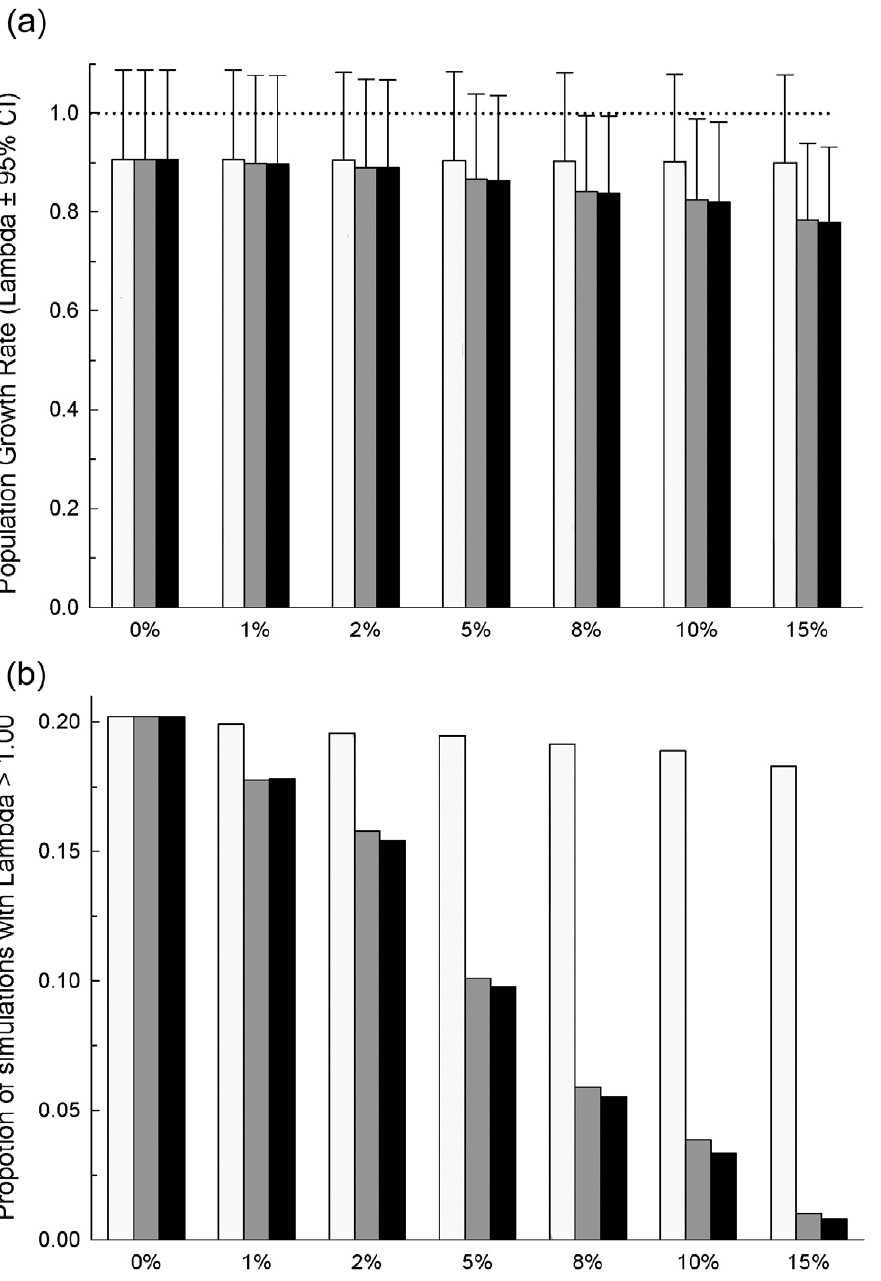
Figure 3. The influence of Paridae pox impacts and prevalence on great tit population growth rate. Results of the age-structured matrix model analysis to assess the influence of Paridae pox impacts and prevalence on the population growth rate (Lambda, l ) of the great tit population: (a) mean population growth rates ( 6 95% CI) obtained from 10000 model runs in which pox impacts were incorporated on fertility rates alone (white bars), survival rates alone (grey bars), or on both vital rates together (black bars), and pox prevalence varied from 0% to 15%; (b) the proportion of each of the 10000 runs which gave l $ 1.